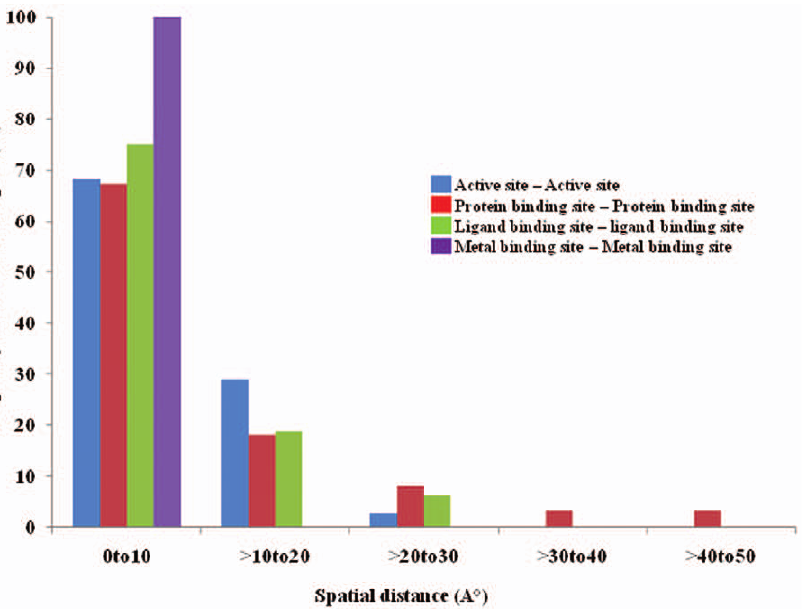
Figure 2. Spatial distribution of coevolved functionally important sites. Frequencies of coevolved functionally important site pairs are plotted versus the spatial distances between them. Bars represent frequencies of coevolved connection within each functional category.